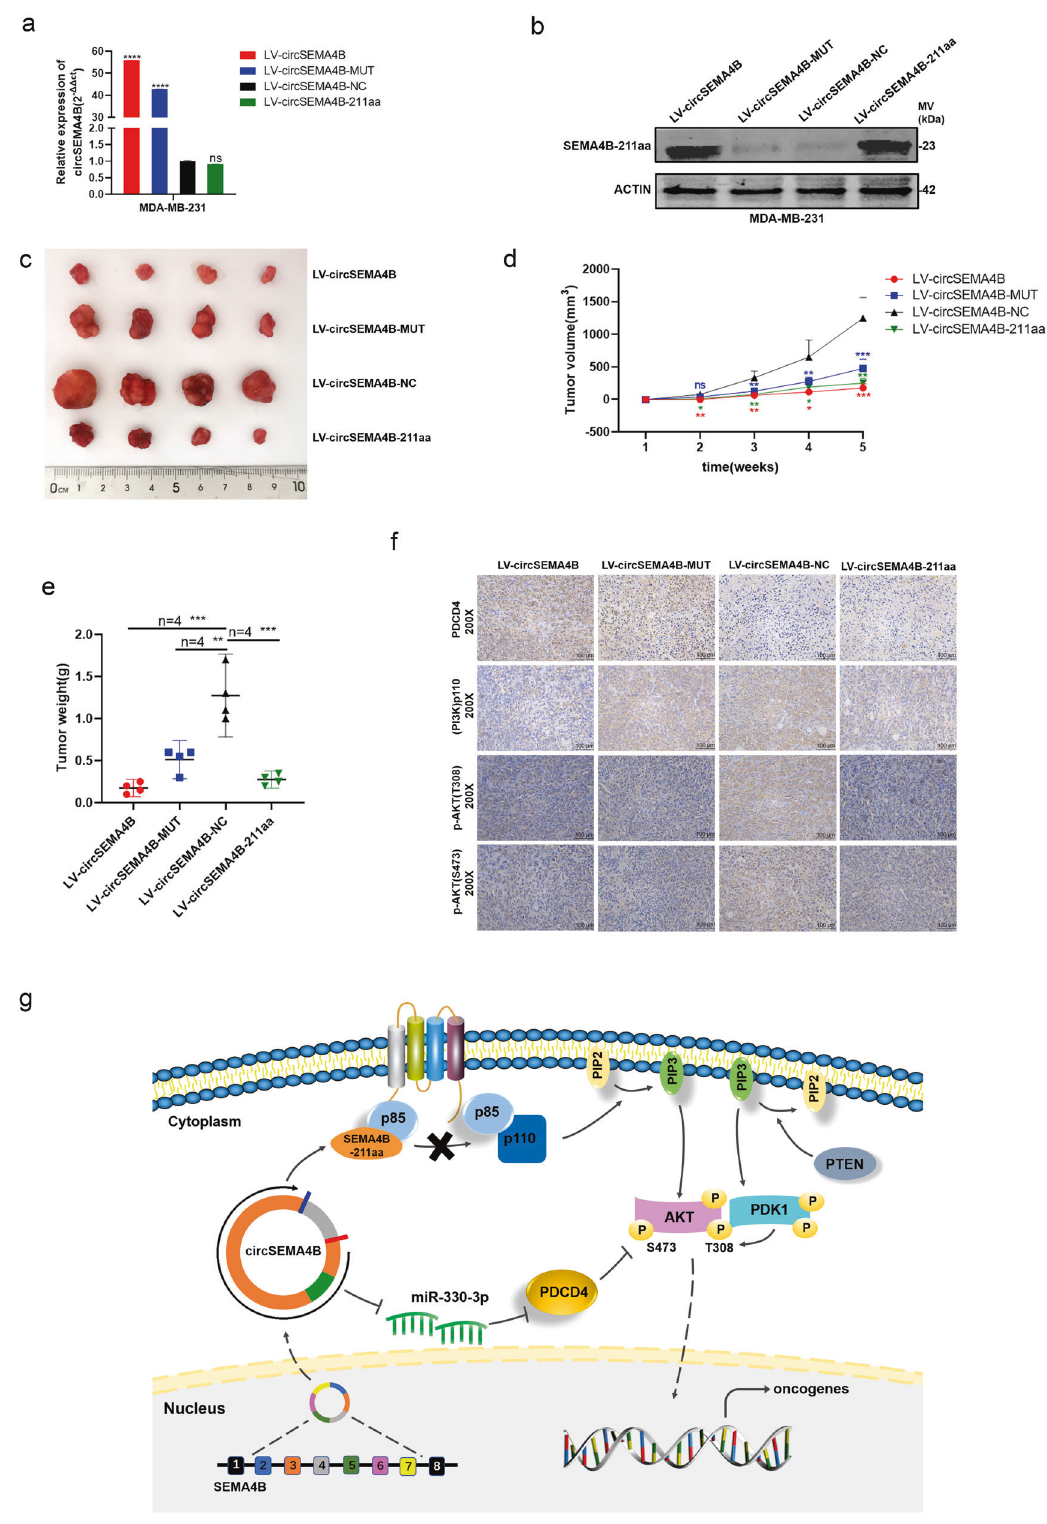
Fig. 8 CircSEMA4B suppresses BC tumorigenicity in vivo. a The transfection ef fi ciency in MDA-MB-231 cells were examined by qRT-PCR. b The transfection ef fi ciency in MDA-MB-231 cells were examined by western blot. c Representative images of xenograft tumors in nude mice. d The growth curves of xenografts. e Average tumor weight of nude mice. f Immunohistochemistry (IHC) staining of PDCD4, p110 and p-AKT (T308/S373) in xenografts. g The mechanism diagram was generated to illustrate the mechanism of circSEMA4B and SEMA4B-211aa in